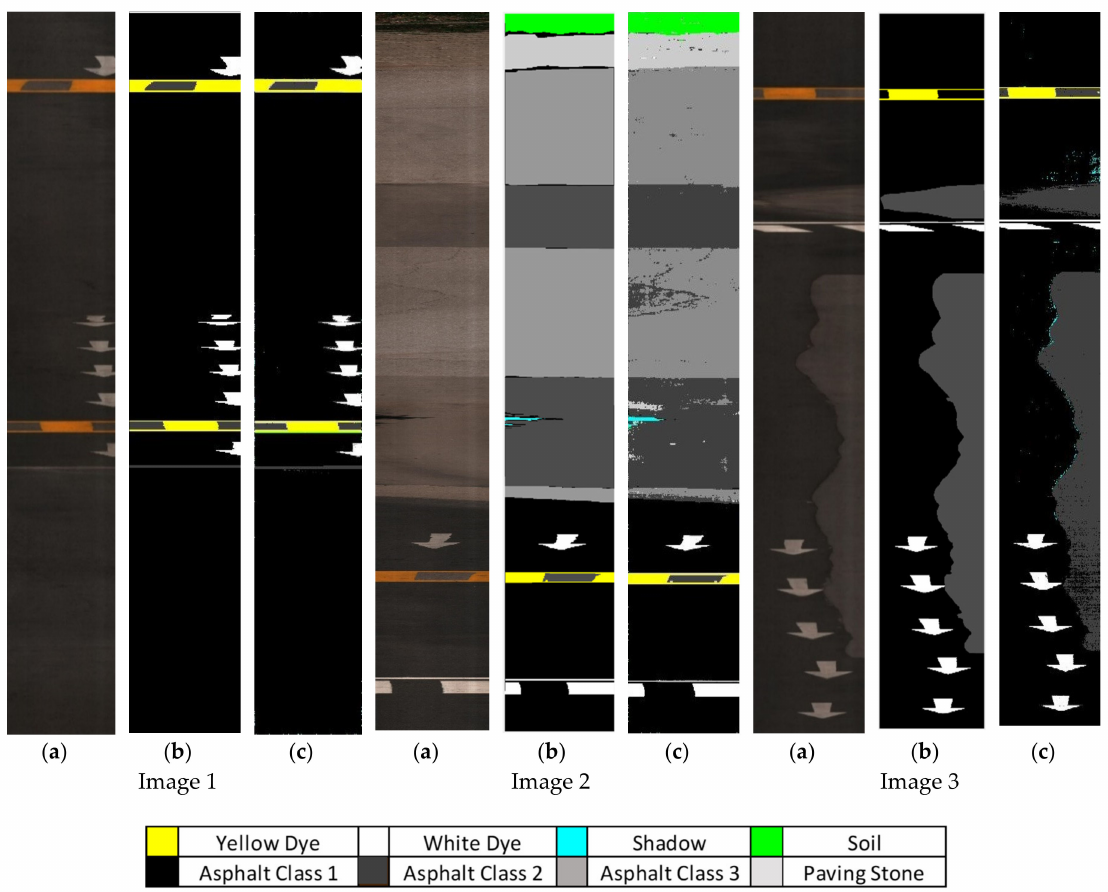
Figure 12. ( a ) RGB image; ( b ) ground truth; ( c ) algorithm outputs of the proposed methodology on the first set of